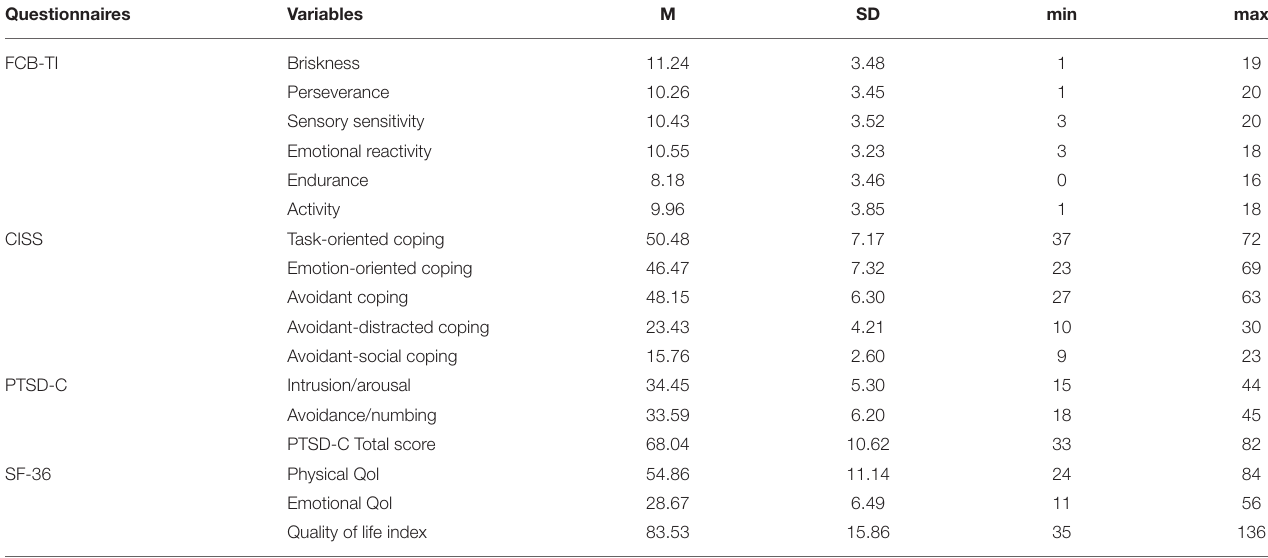
TABLE 2 | Descriptive statistics for interval scales.